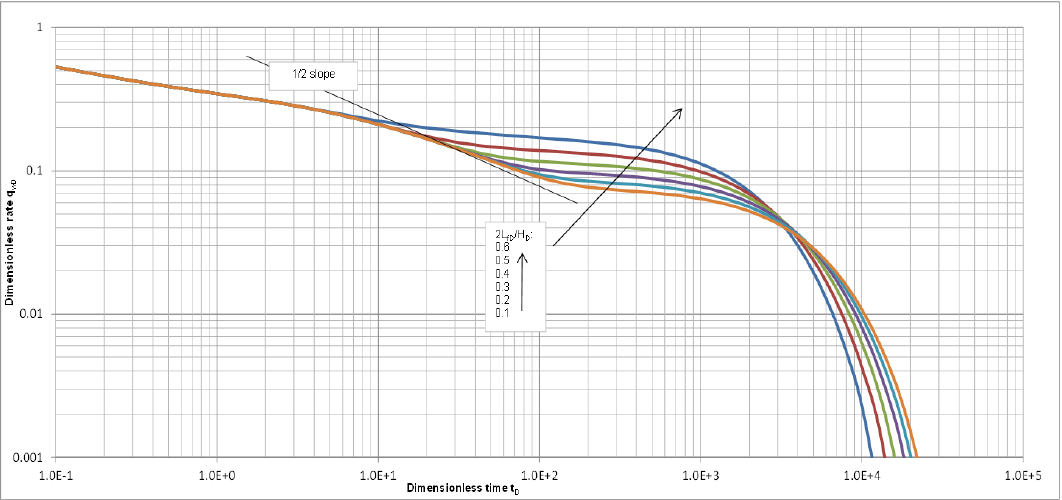
2𝐿 𝑓𝐷 , with , with 𝐻 𝐷 H D